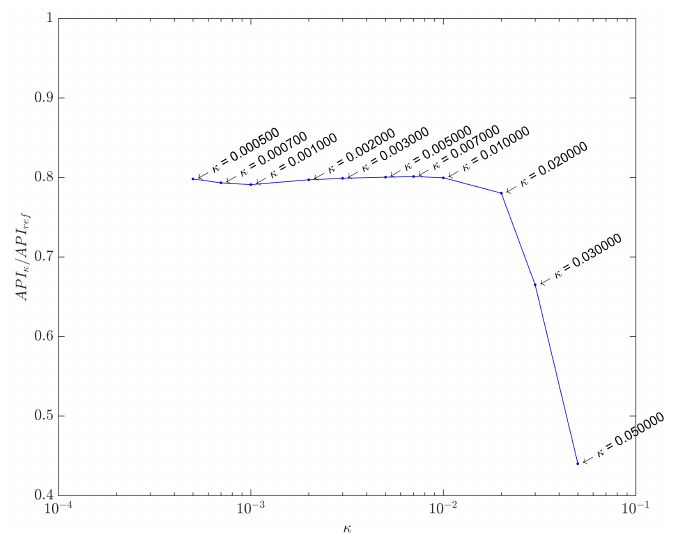
Figure 11. Array Performance Indicator (API) ratio curve. Solutions for each κ were computed with Iterative Re-weighted Least Squares (IRLS), running 30